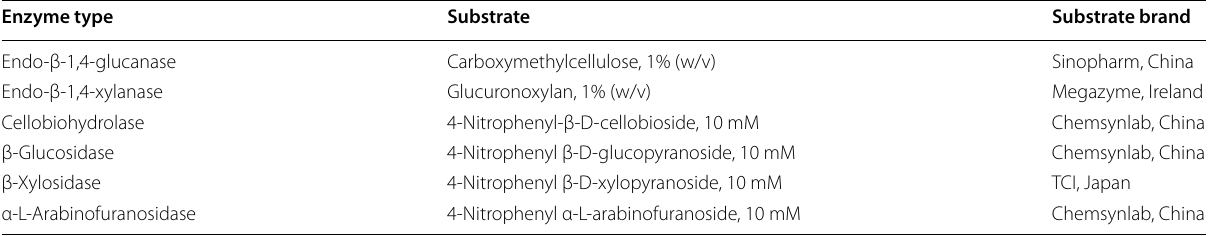
Table 1 Substrates and reaction conditions for enzymatic assay Enzyme type